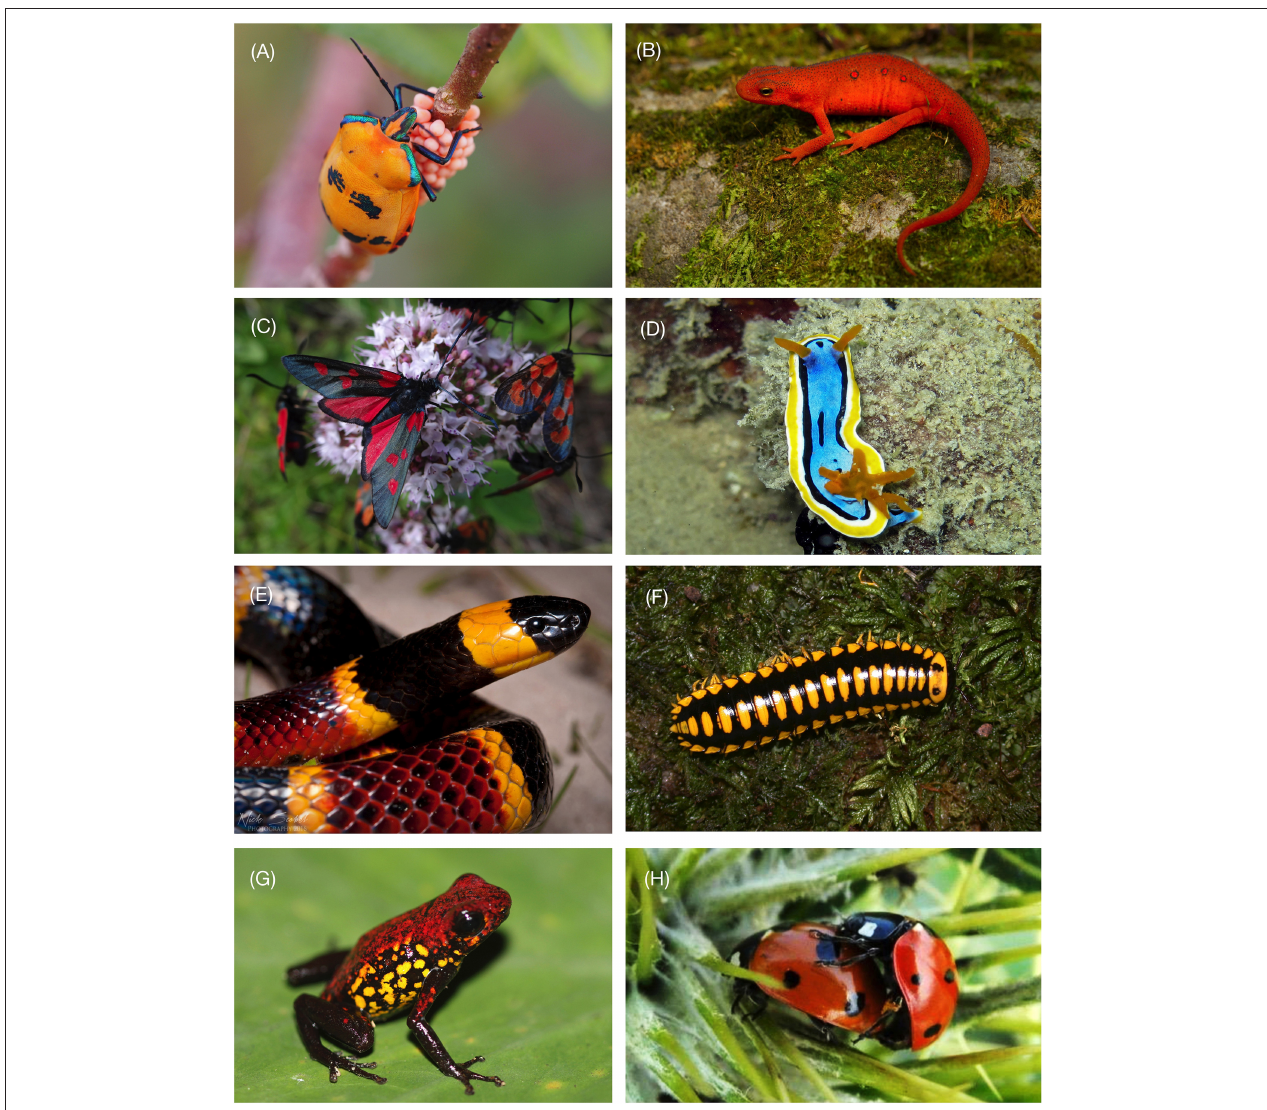
FIGURE 3 | Aposematism is widespread across the animal kingdom. (A) Harlequin bug, Tectocoris diophthalmus ; (B) Eastern newt (eft form), Notophtalmus viridescens ; (C) Burnet moths, Family Zygaenidae; (D) Sea slug, Chomodoris annae ; (E) Eastern coral snake, Micrurus fluvius ; (F) Appalachian mountains millipede, Apheloria polychroma ; (G) Harlequin poison frog, Oophaga occultator ; (H) ladybird, family Coccinelidae. Photos: (A) E. Burdfield-Steel; (B,D) JP Lawrence; (C,H) B. Rojas; (E) N. Scobel; (F) P. Marek; (G) P.